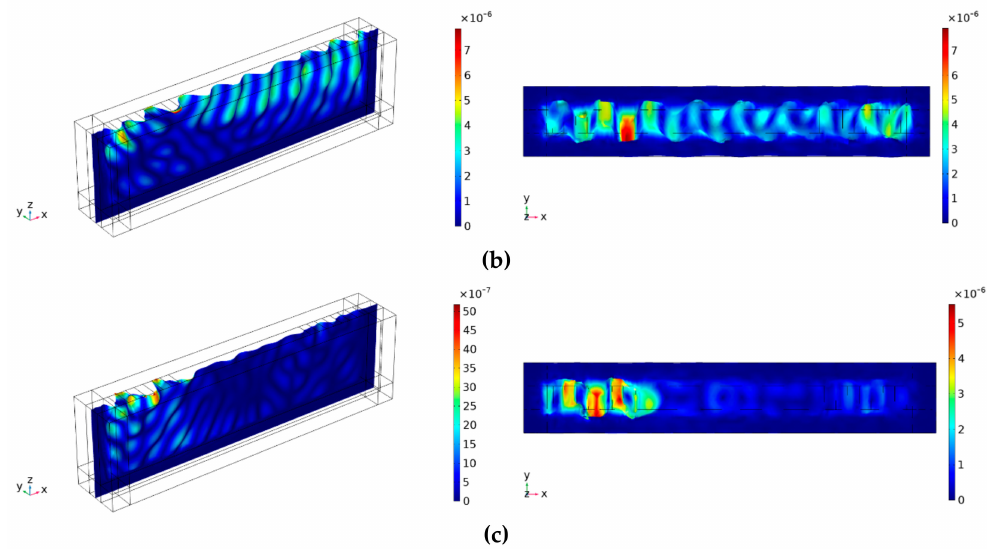
Figure 5. Snapshots of sectional views from di ff erent substrates: ( a ) Y + 36 ◦ cut at 407 MHz; ( b ) Y + 36 ◦ cut at 449 MHz; ( c ) Y − 51 ◦ cut at 470 MHz.